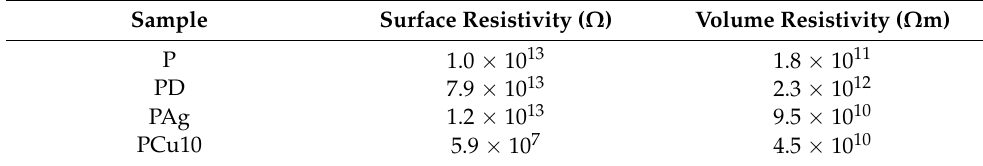
Table 3. Surface and volume resistivity of tested